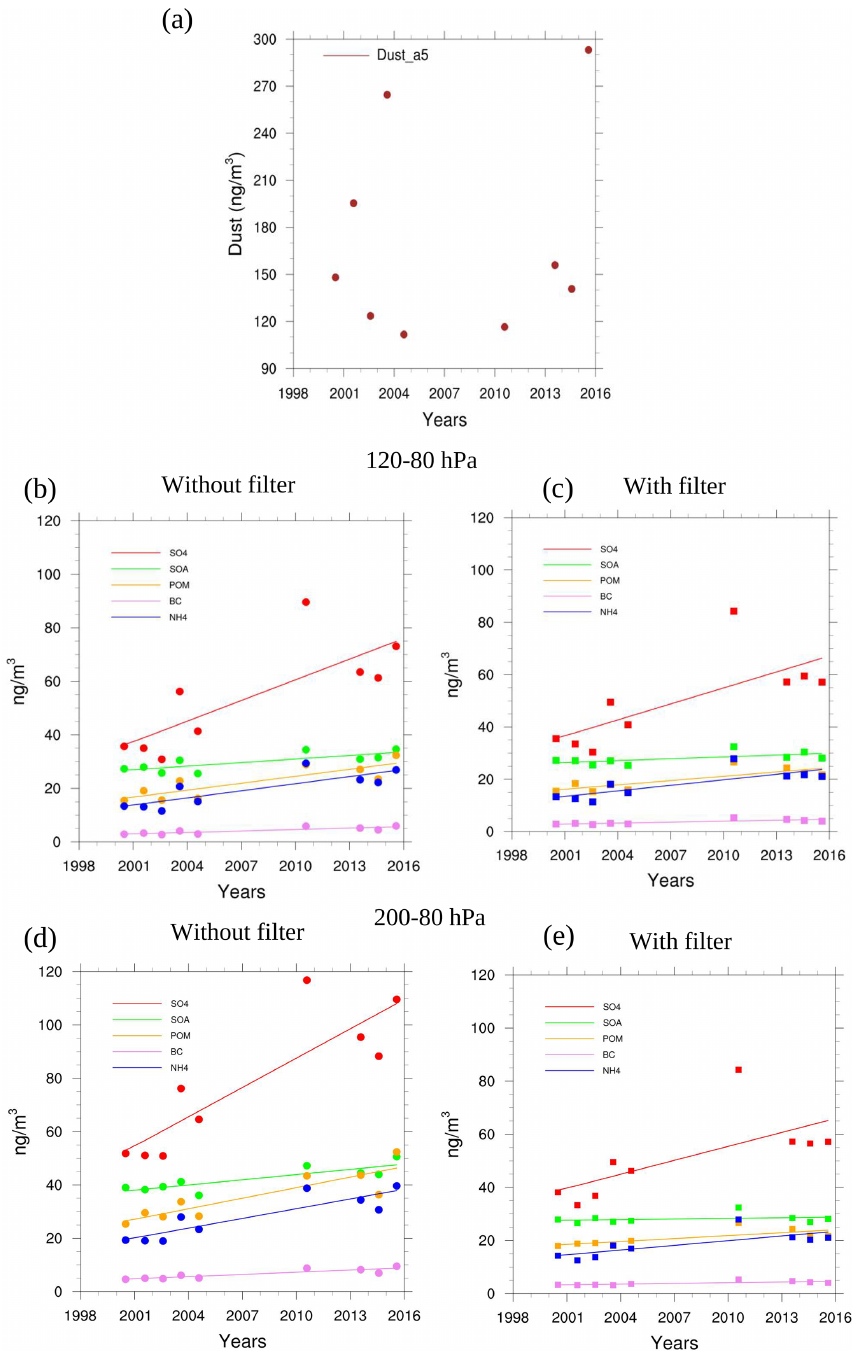
Figure 5. Aerosol mass concentration trends simulated by CESM-MAM7 averaged between 20–35 ◦ N and 60–100 ◦ E for July and August. (a) For dust in the fine soil dust mode between 120 and 80hPa and, (b) respectively, for SO 4 , SOA, POM, BC, and NH 4 in the accumulation mode between 120 and 80hPa. (c) Same as (b) but with the extinction filter applied. (d) and (e) : same as (b) and (c) but averaged between 200 and 80hPa. The plots show the trends excluding the years with volcanic eruptions impacting the UTLS.